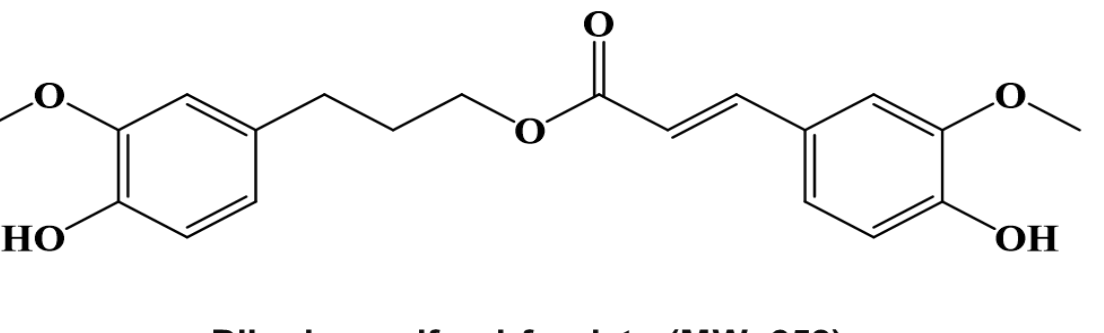
Figure 1. Purification of a breast CSC inhibitor from Dendropanax morbiferus H.Lév. using fractiona- tion guided by a mammosphere assay. ( A ) Isolation protocol for the inhibitor of mammosphere formation from Dendropanax morbiferus H.Lév. ( B ) Effect of the purified inhibitor from Dendropanax morbiferus H.Lév. on mammosphere formation using MDA-MB-231 cells. Images were analyzed us- ing microscopy at 10× magnification (scale bar = 100 µm). ( C ) HPLC data for the isolated samples from Dendropanax morbiferus H.Lév.